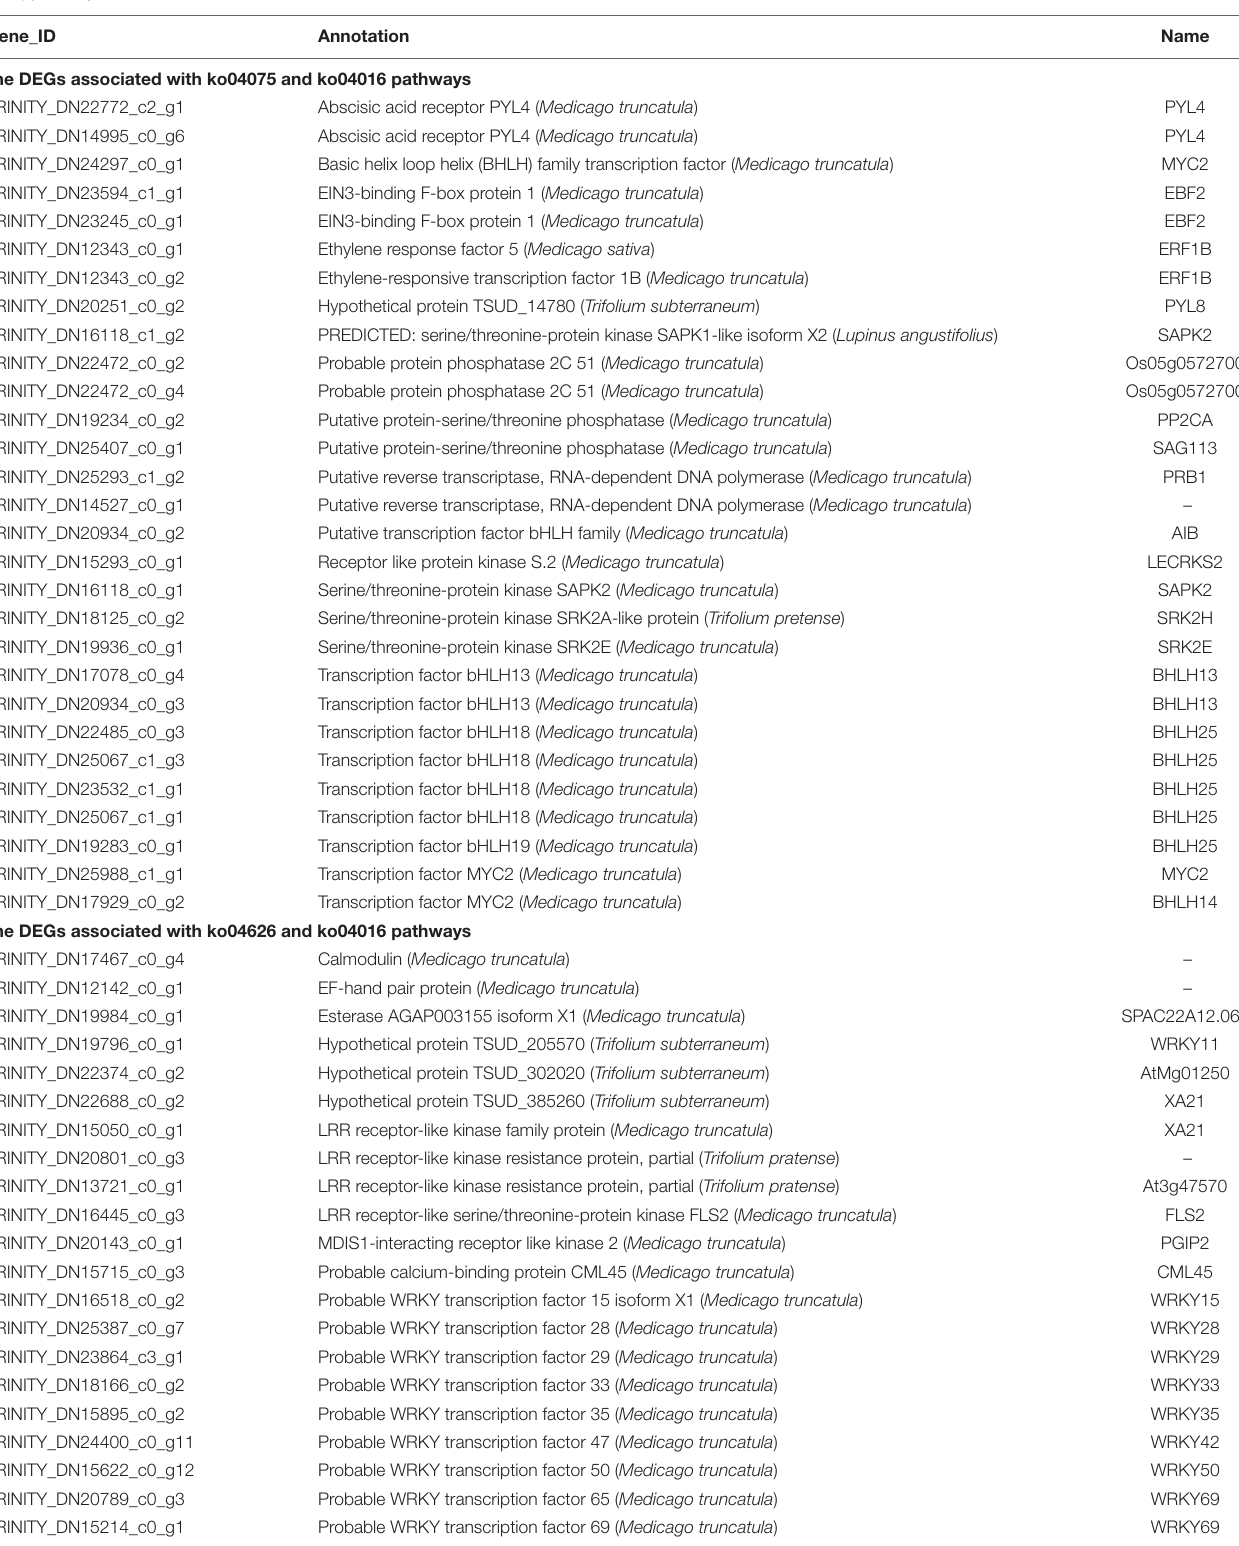
TABLE 3 | The DEGs associated with ko04075 (plant hormone signal transduction), ko04626 (plant–pathogen interaction), and ko04016 (MAPK signaling pathway – plant) pathways. Gene_ID